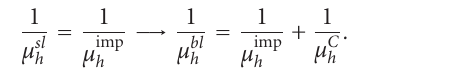
though the relative change in resistance appears to be much larger in the hole layer. However, the loss of conductivity in both layers between 2 K and 50 mK (inset Figure 19) is sim- ilar ( ∼ 0.2 mS), over which the insulating behaviour is seen. This is much larger than the change weak localisation (quan- tum interference) can account for ( Δ σ xx ≈ 40 μ S) [75]. Weak